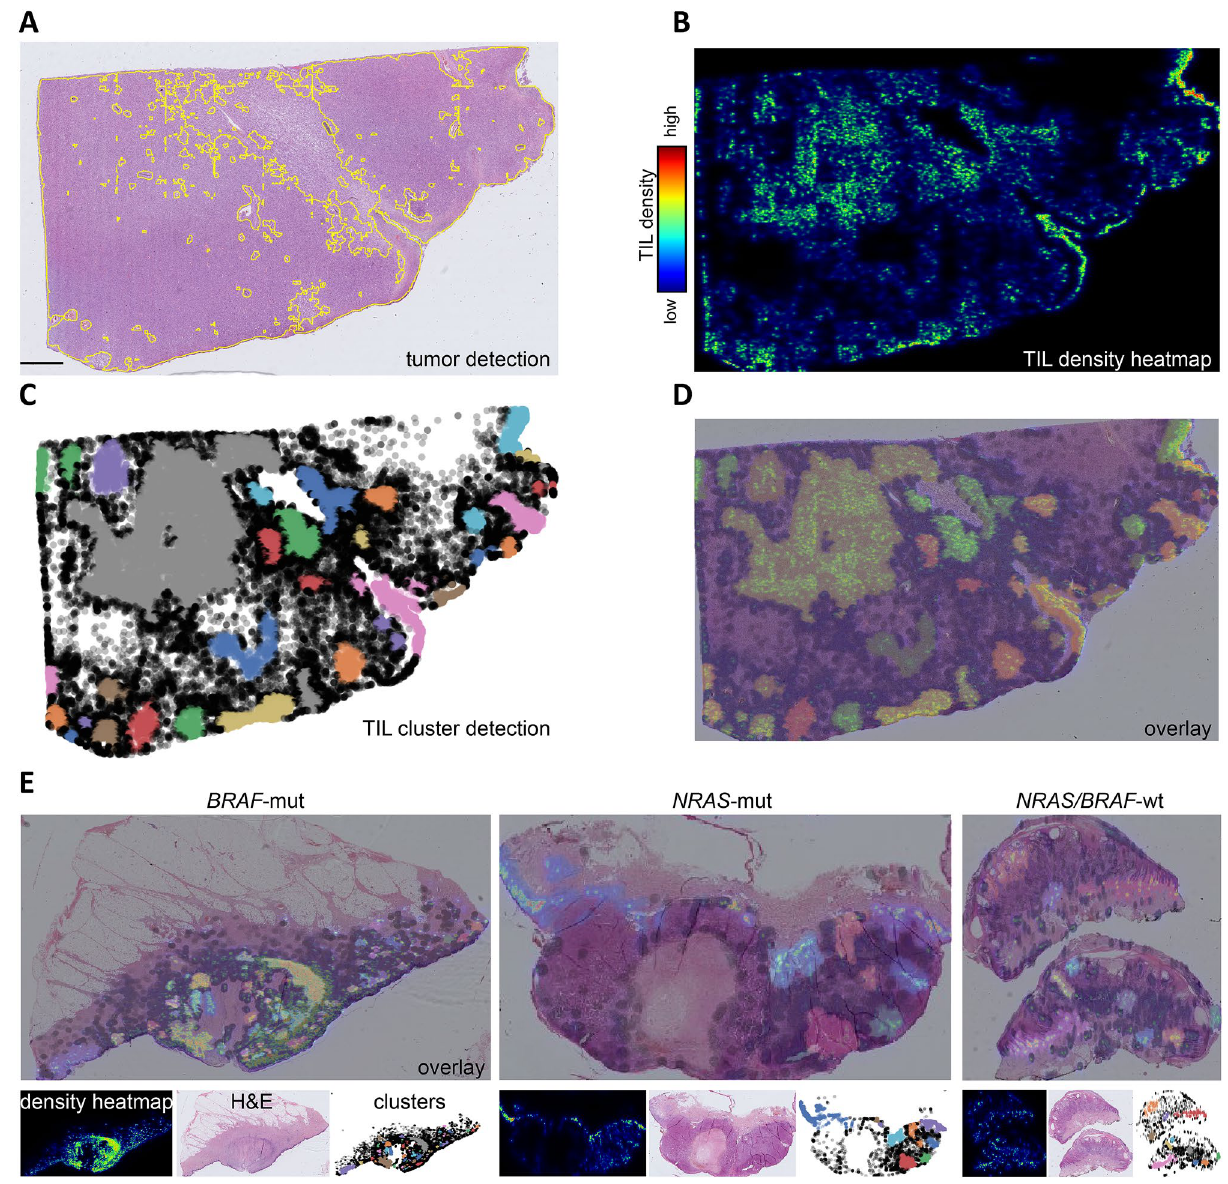
Figure 1. Detection of viable tumor areas and TIL clusters using regular H&E whole-slide-images of malignant melanomas. Illustration of tumor segmentation using regular H&E stains of cases of malignant melanoma, with visualizations of TIL detection and TIL clustering using single images and combined overlays. ( A ) H&E stains of one representative case of malignant melanoma with segmentation of viable tumor areas with help of a deep convolutional neural network (U-Net). The yellow line represents the segmentation of tumor area, while necrotic areas are left out. ( B ) Subsequent TIL detection within viable tumor areas and illustration of TILs using a density heatmap where red indicates high density of TILs and blue indicates low density, according to the legend. ( C ) Visualization of TIL cluster detection. Black circles indicate individual TILs and colored areas highlight distinct TIL cluster that had been assigned using HDBSCAN 12 . ( D ) Overlay of the images from panels A-C with transparent layers combining H&E image, TIL density heatmap and TIL clusters. ( E ) Panel of BRAF - mut ( V600 E/K ) NRAS -mut and BRAF/NRAS -wildtype samples, where the overlay is shown in the upper panel and the given TIL density heatmap, TIL clustering and H&E images are shown